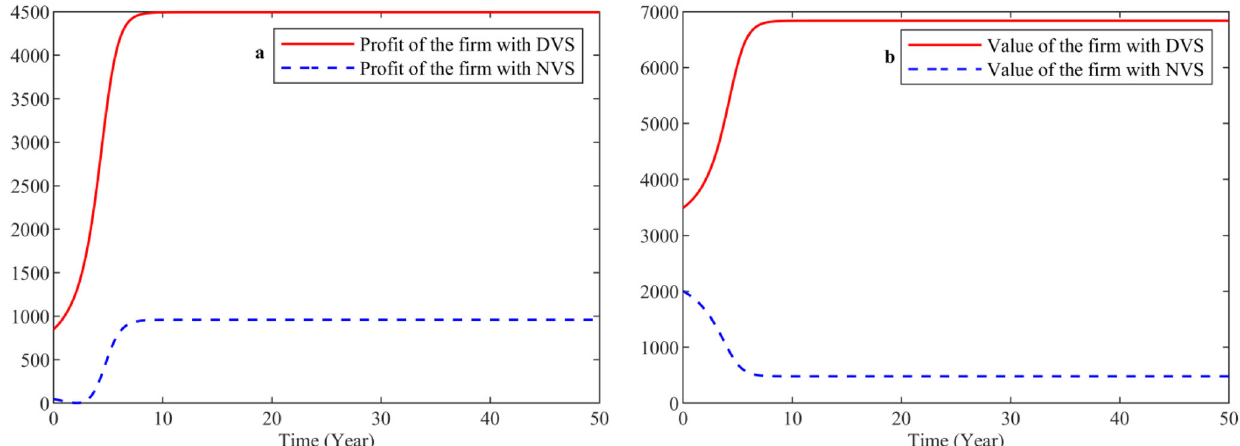
Fig. 7 Evolution of pro fi t and value with DVS and NVS. a Evolution of pro fi t with DVS and NVS. b Evolution of fi rm value with DVS